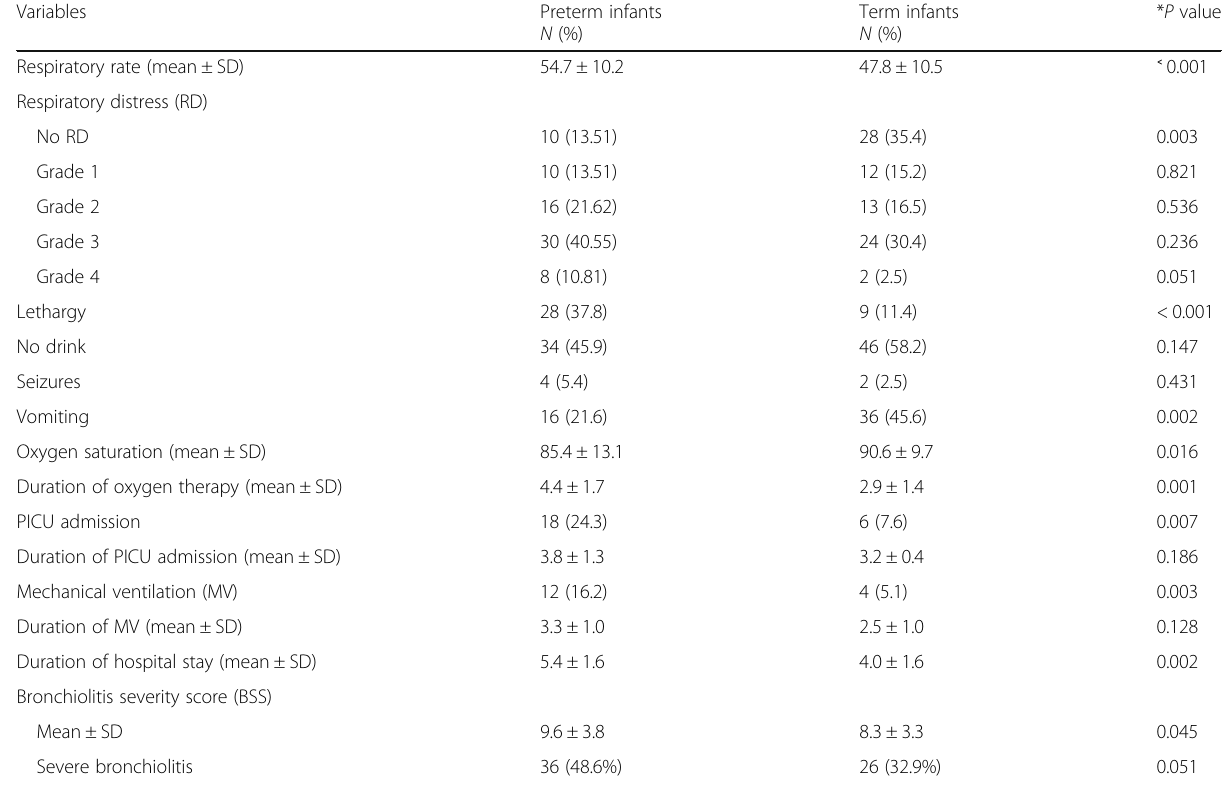
Table 2 Clinical findings on presentation and outcomes of the preterm and the term infants with bronchiolitis